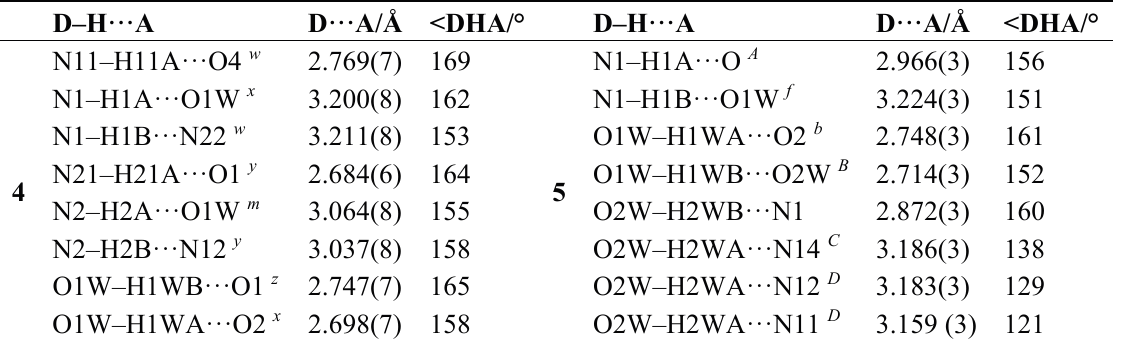
Table 5. Geometrical details on the hydrogen bonds present in the supramolecular networks [Cd(Hatrc) 2 (H 2 O)] n ( 4 ) and [Mn(atrc)(H 2 O)] n · n H 2 O ( 5